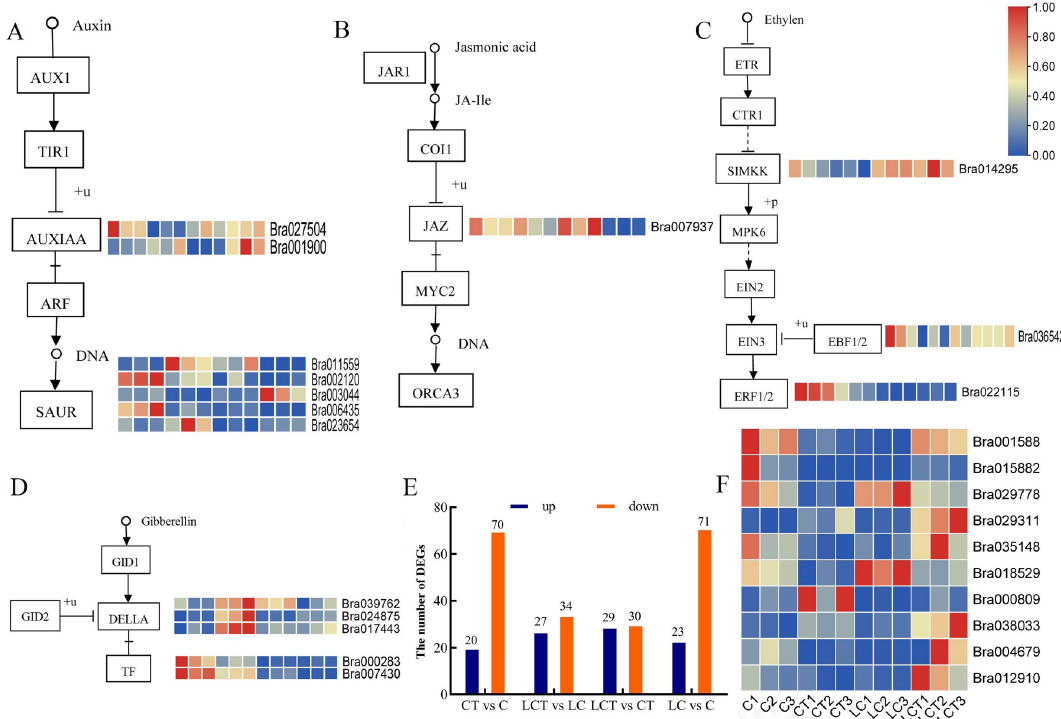
Fig 8. Hormone metabolic pathway and heat map of related transcription factors. A, B, C, D, Schematic diagram of gene expression related to hormone signal transduction pathway; E, Statistical histogram of 661 differential genes; F, Differential transcription factor